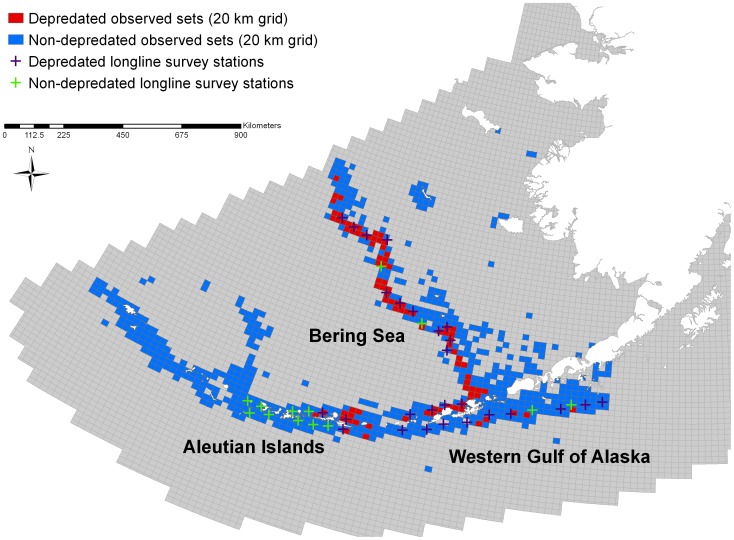
NMFS Longline Survey Stations and Observer Sets Sampled 1998–2012.Map of western Alaska regions with depredated and non-depredated sets based on NMFS observer data and depredated and non-depredated stations based on the NMFS annual sablefish longline survey. Observer data are aggregated by 20 km grids for confidentiality.